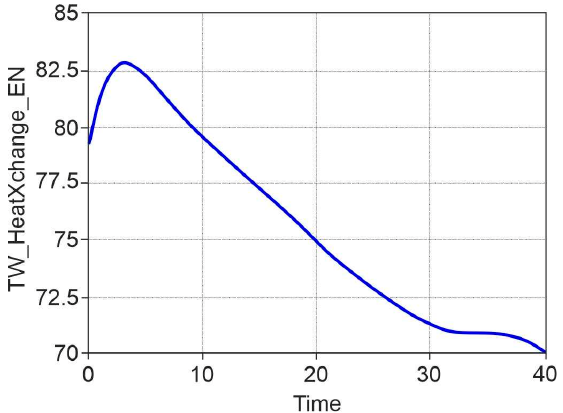
Figure 8. Change in heat flux in the system circuit during the warming of blood at the outlet of the model EN of refrigerant condensation in time. model EN of refrigerant condensation in